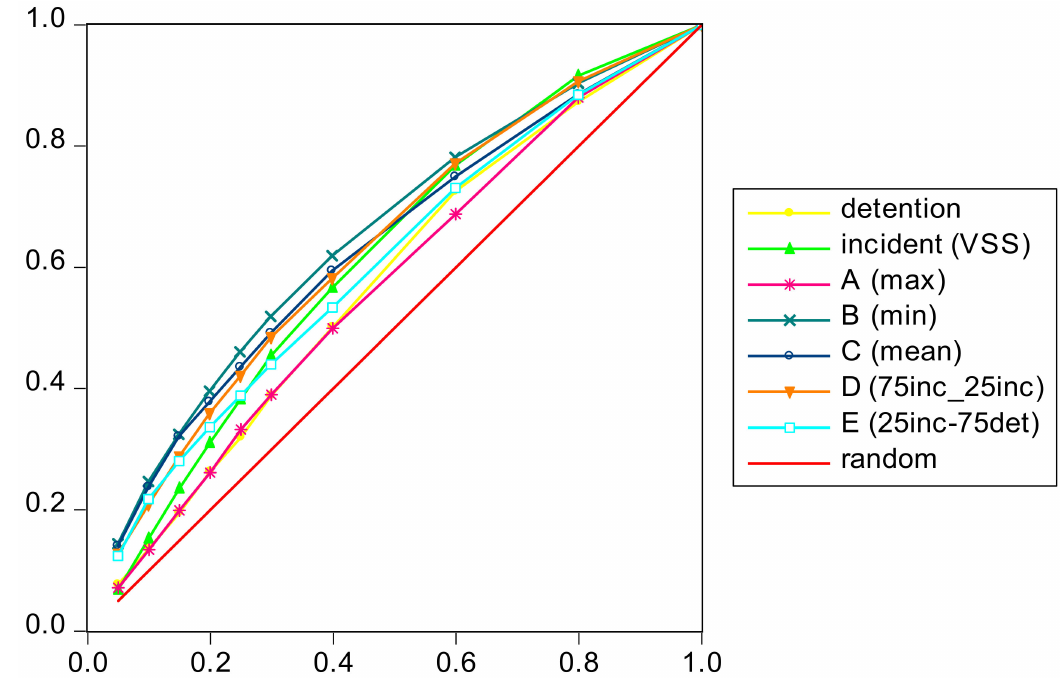
Figure A3. ROC curve—evaluation variable VSS and detention: total count